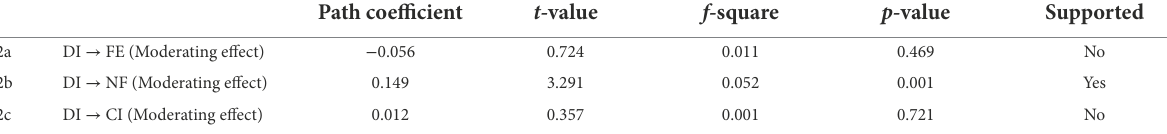
TABLE 5 Moderation effect test.